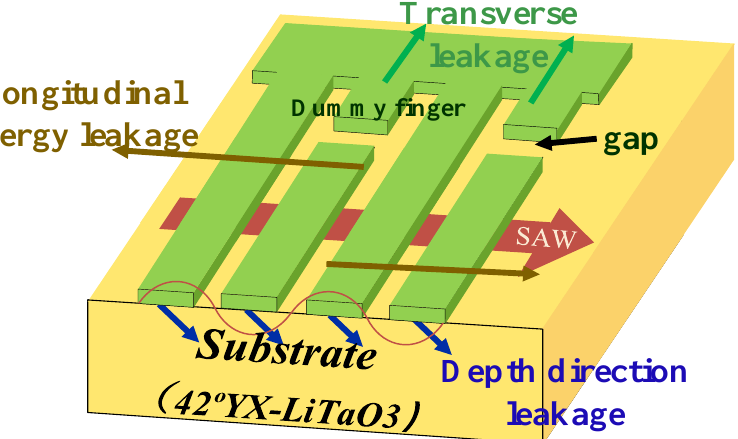
Figure 1. Energy leakage chart.